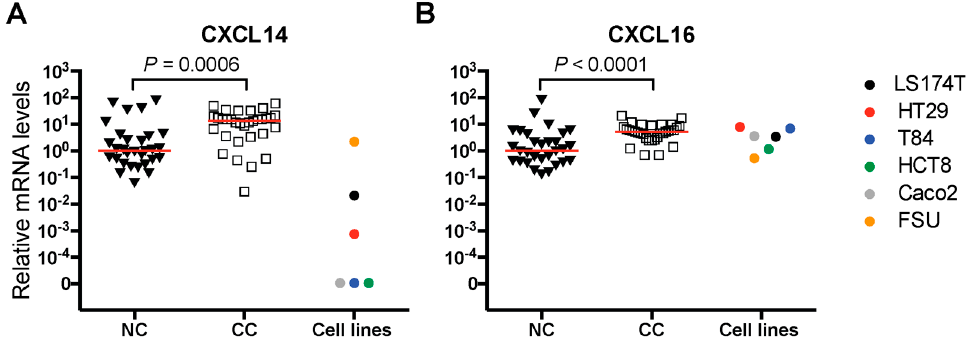
Figure 1. Relative mRNA levels of CXCL14 ( A ) and CXCL16 ( B ) in primary colon cancer tissues (CC) compared to adjacent normal colon margins (NC). Relative mRNA levels in the 5 CC cell lines; LS174T, HT29, T84, HCT8 and Caco2, and primary foreskin fibroblast cells (FSU) is also depicted (Cell lines). Relative mRNA levels were calculated as described in the Materials and Methods section. Red horizontal lines indicate median values . P -values were calculated by two-tailed Mann-Whitney test.